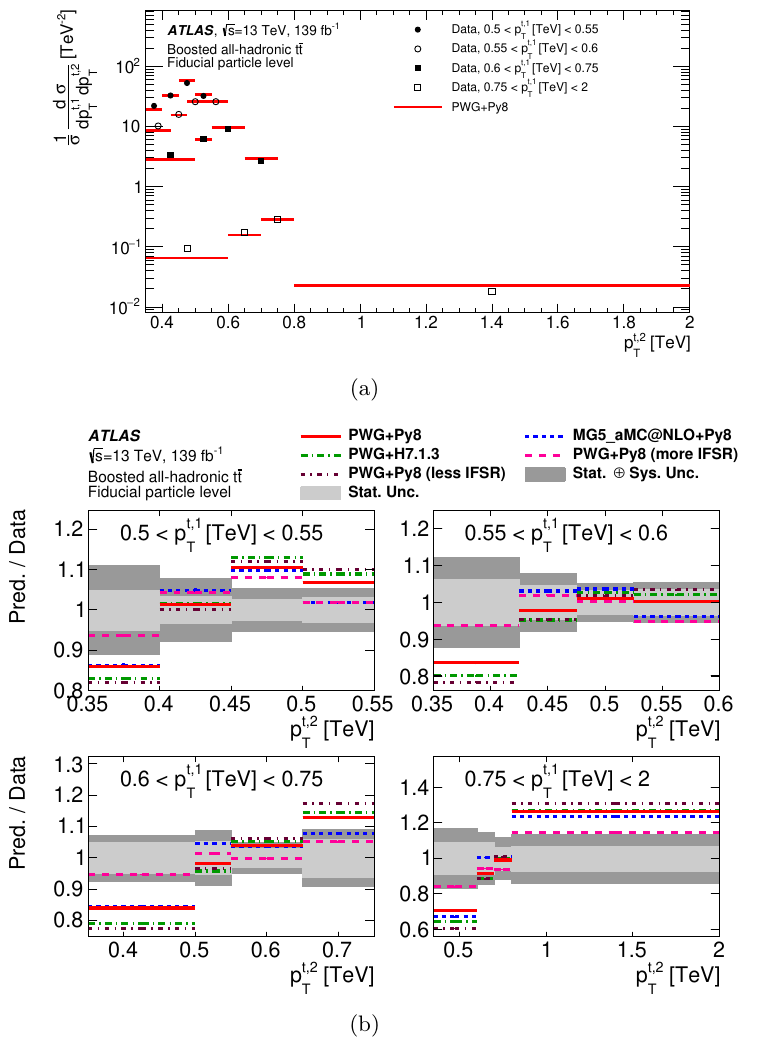
Figure 13 . (a) Normalized particle-level fiducial phase-space double-differential cross-sections as a function of the transverse momenta of the leading and second-leading top-quark jets, compared with the Powheg+Pythia 8 calculation. Data points are placed at the centre of each bin and the Powheg+Pythia 8 calculation is indicated by solid lines. (b) The ratios of various MC calculations to the normalized particle-level fiducial phase-space differential cross-sections. The dark and light grey bands indicate the total uncertainty and the statistical uncertainty, respectively, of the data in each